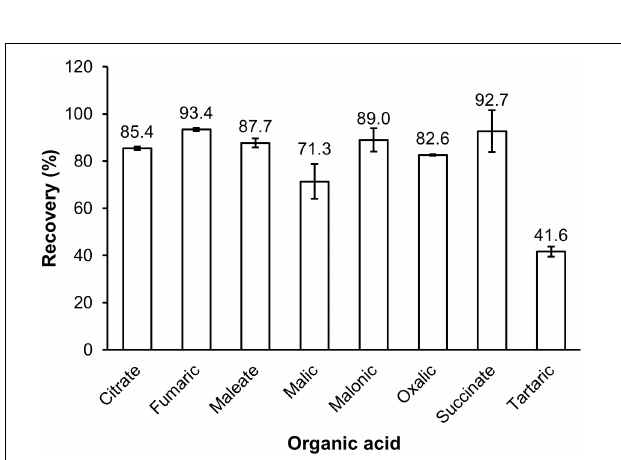
FIGURE 4 | The recovery of organic acids extracted by THF from soil solution spiked organic acids. Data represents the mean and standard error of four biological